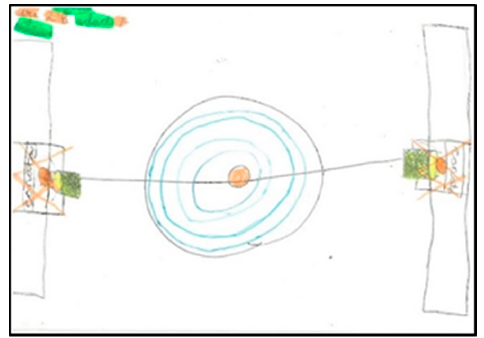
Figure 18. Number of figures present. Juanma. 1°B.